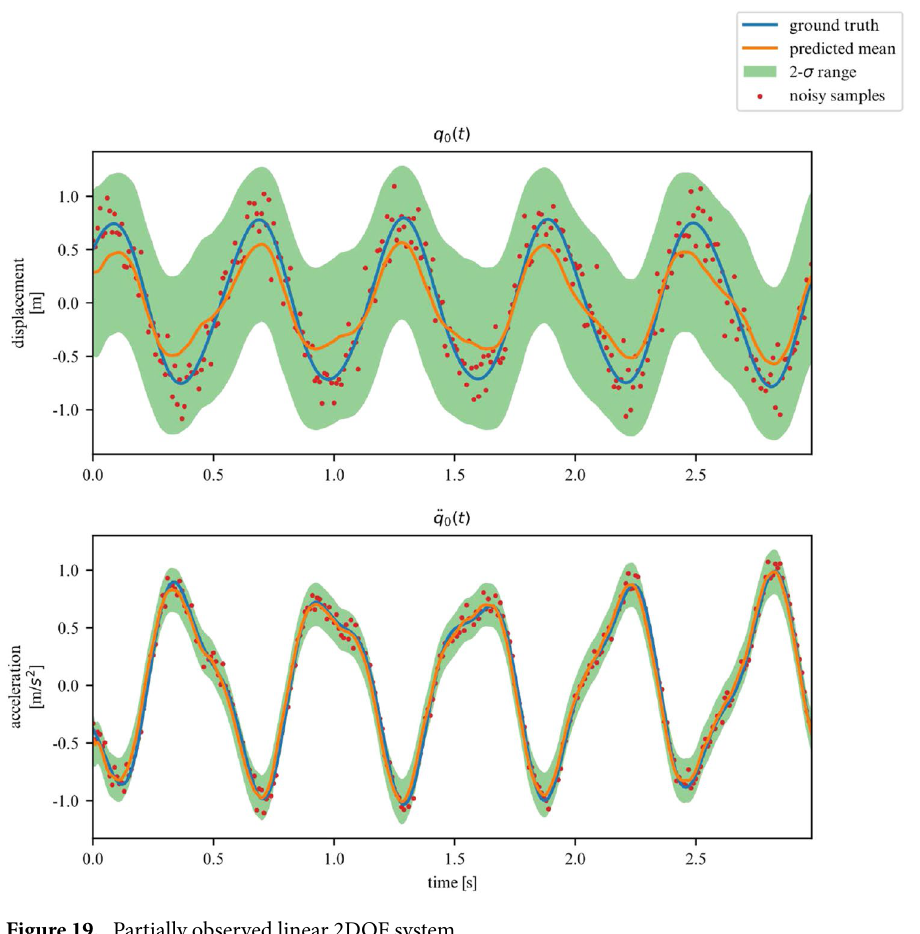
Figure 19. Partially observed linear 2DOF